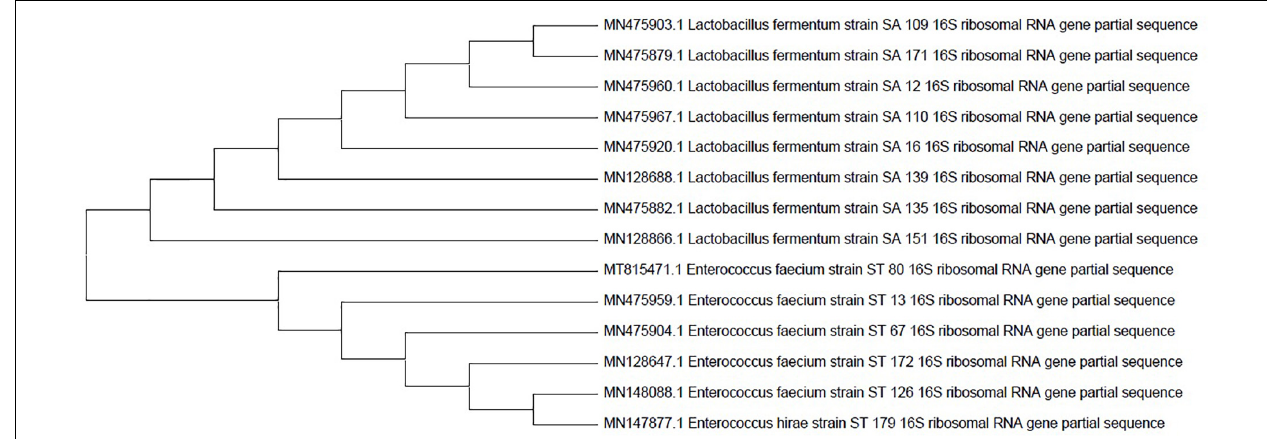
FIGURE 2 | Phylogenetic tree of the 14 probiotic isolates based on 16s rRNA sequences. The tree was constructed by the MEGAX software using the bootstrap method.